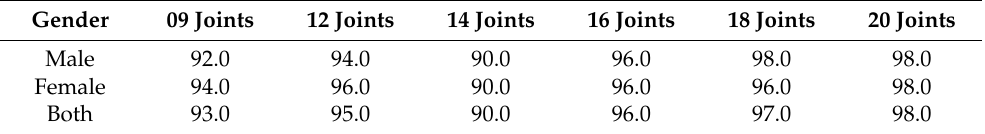
Table 6. Classification accuracy of the proposed system with different set of joints.